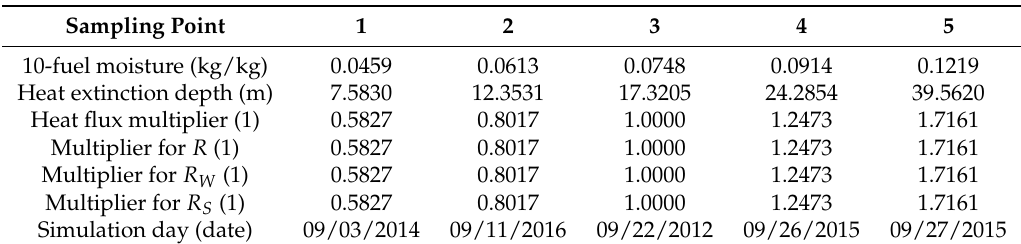
Table 4. Sampling points for Latin Hypercube